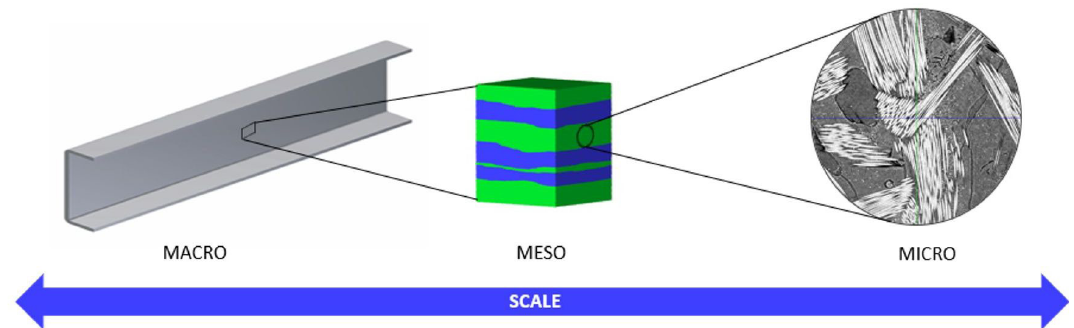
Figure 15. Pultruded GFRP at different